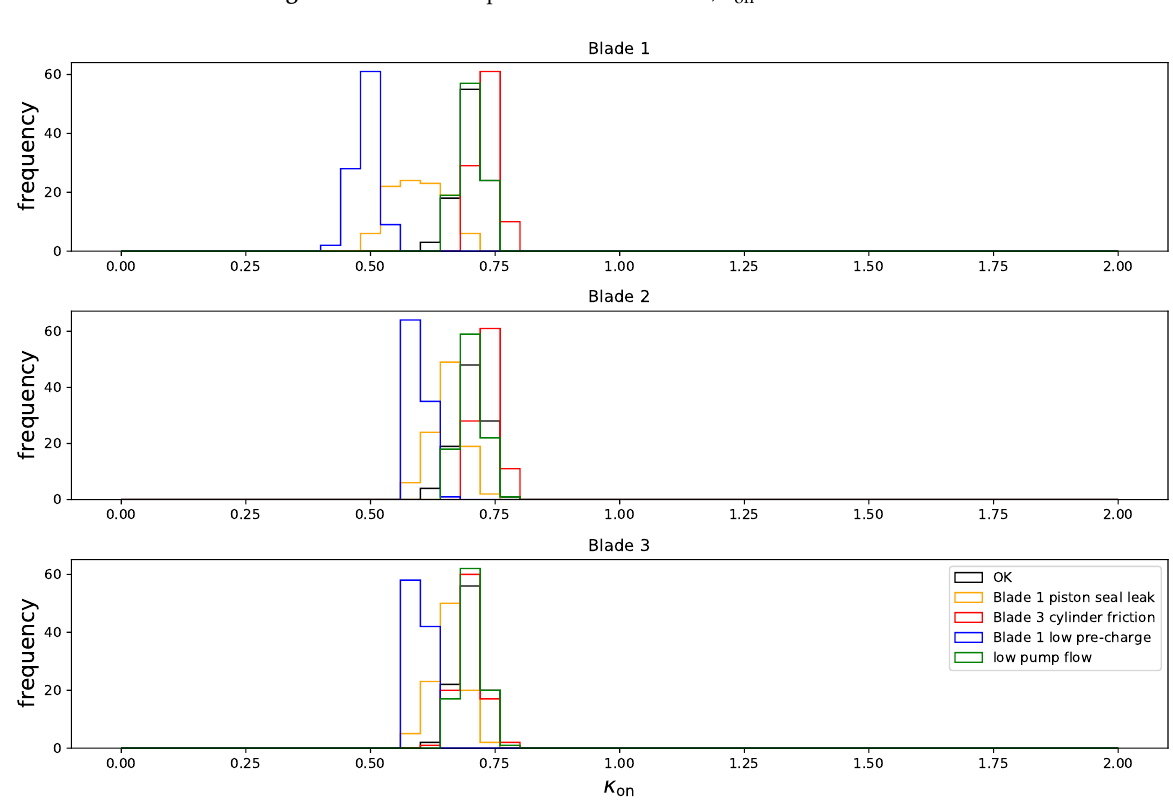
Figure 15. Simulation parameter distribution, κ on